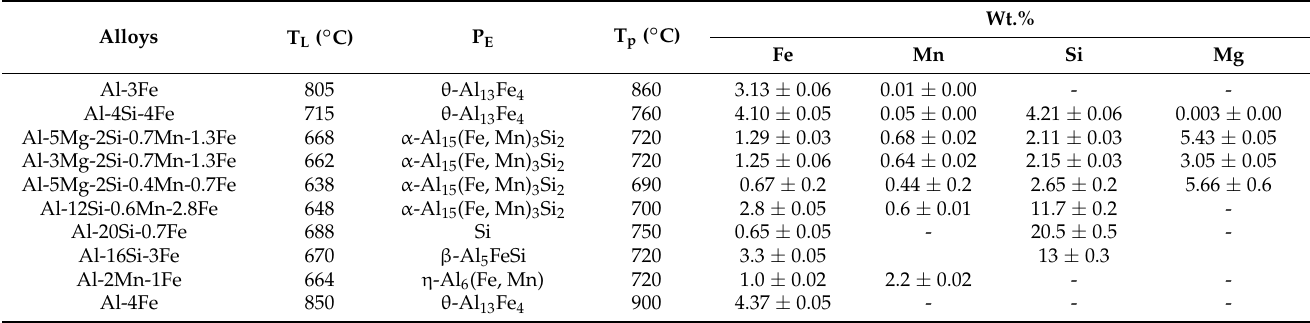
Table 2. The composition (wt.%) of different Al alloys investigated in this